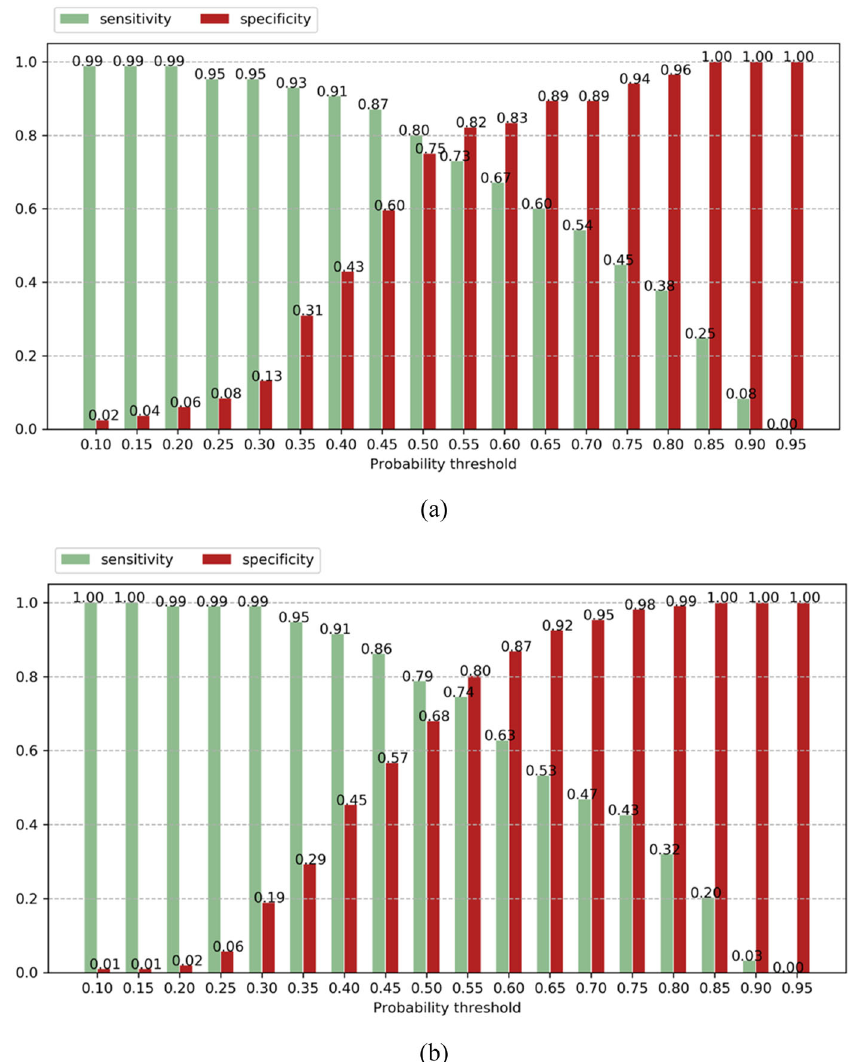
Fig. 2 (Sensitivity vs. speci fi city plot): Sensitivity and speci fi city across different operating point (probability threshold) with increment of 0.05 on the Stanford internal test set ( a ) and Intermountain external test ( b